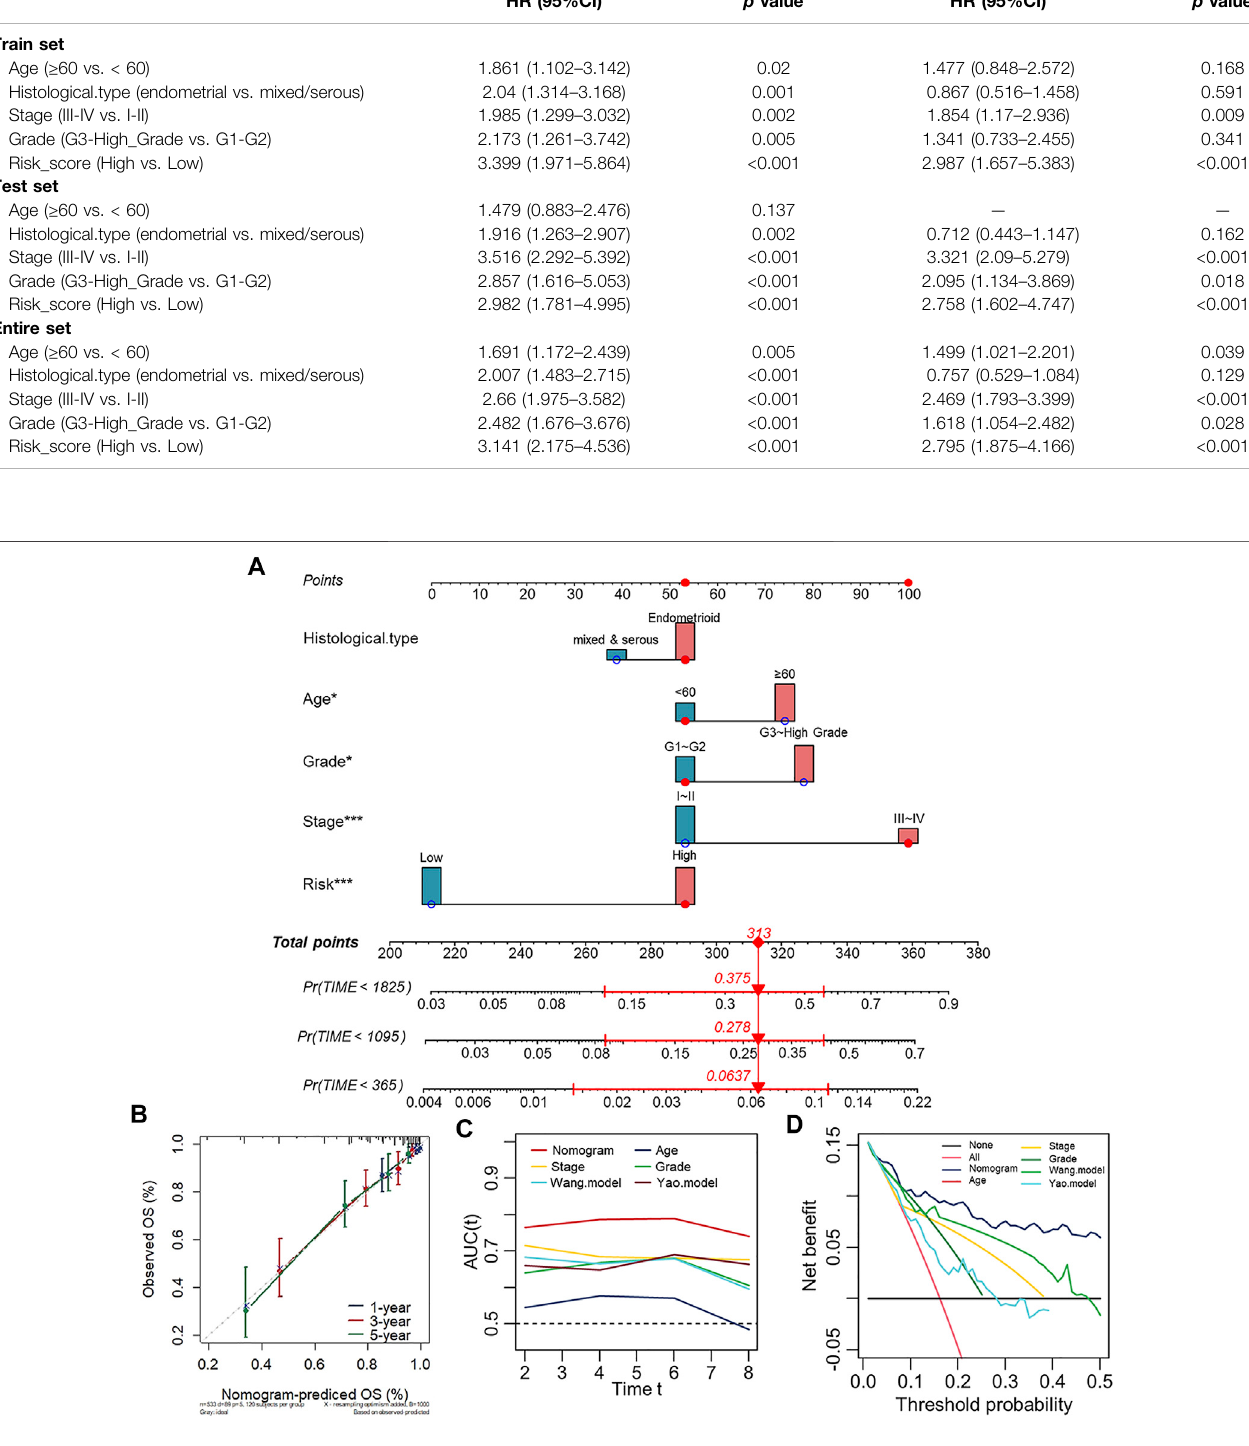
Frontiers in Molecular Biosciences |